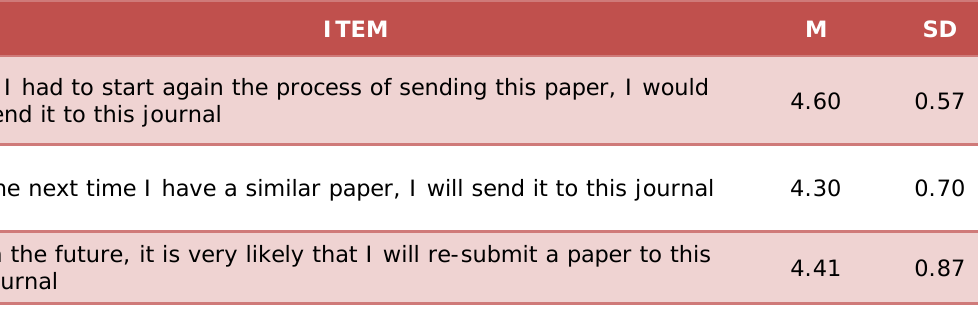
Table 5. “Intention to re-submit a paper to